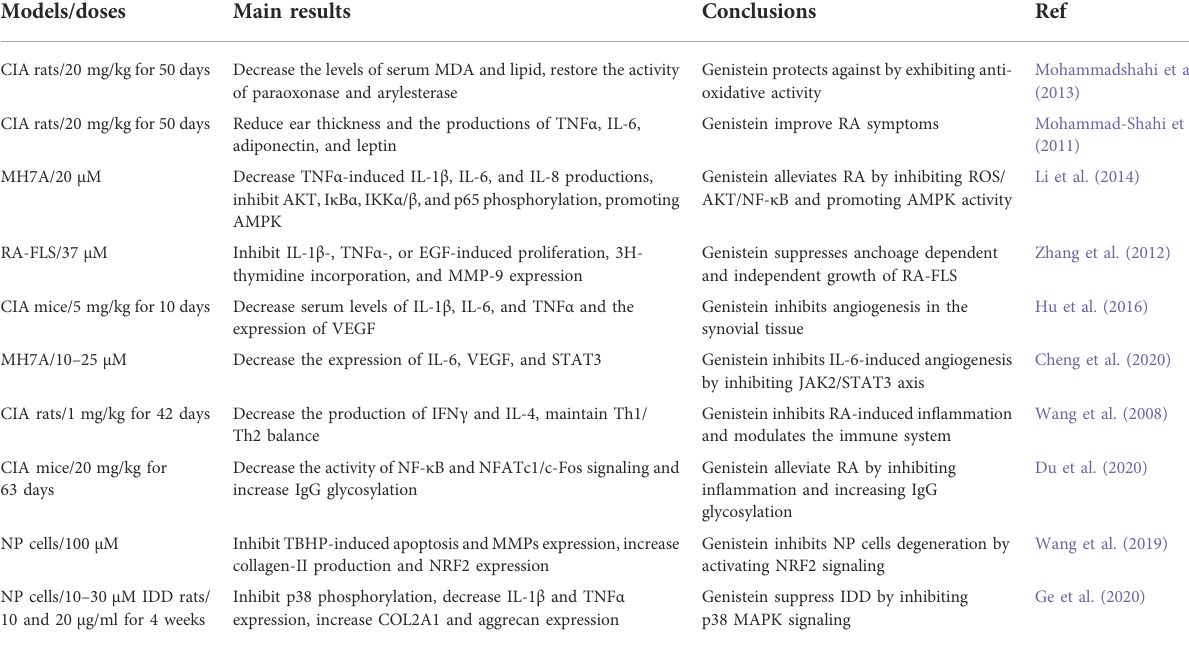
TABLE 3 The biological effects of genistein on RA and